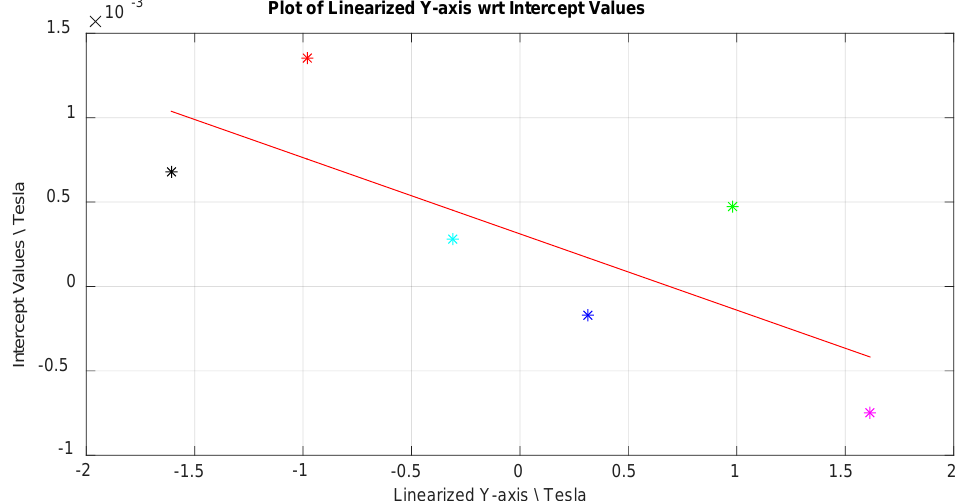
Figure 17. Graph showing the intercept values of the errors as in Figure 13 for each plateau. A linear polynomial fit is deemed best in characterizing all the intercept values across the whole range.